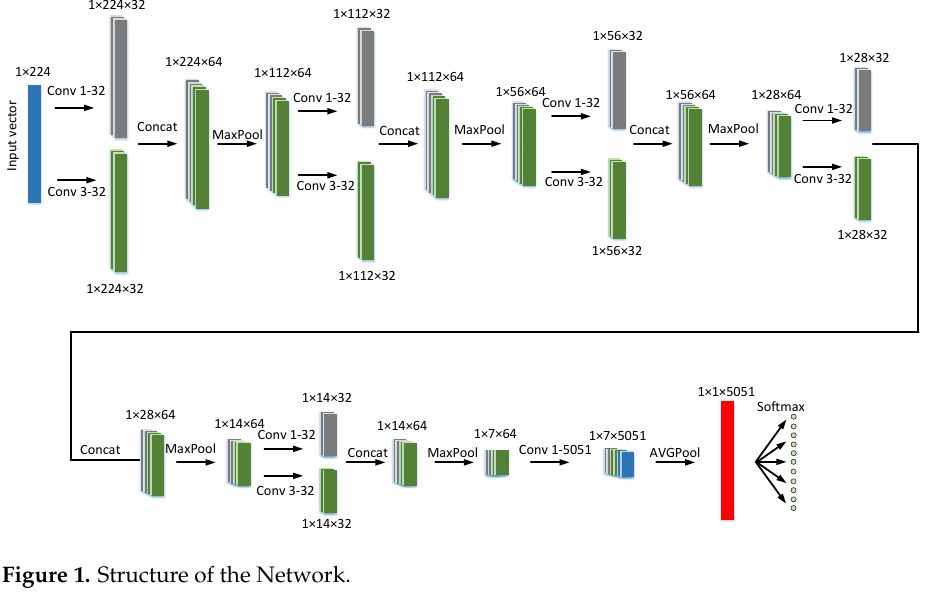
Figure 1. Structure of the